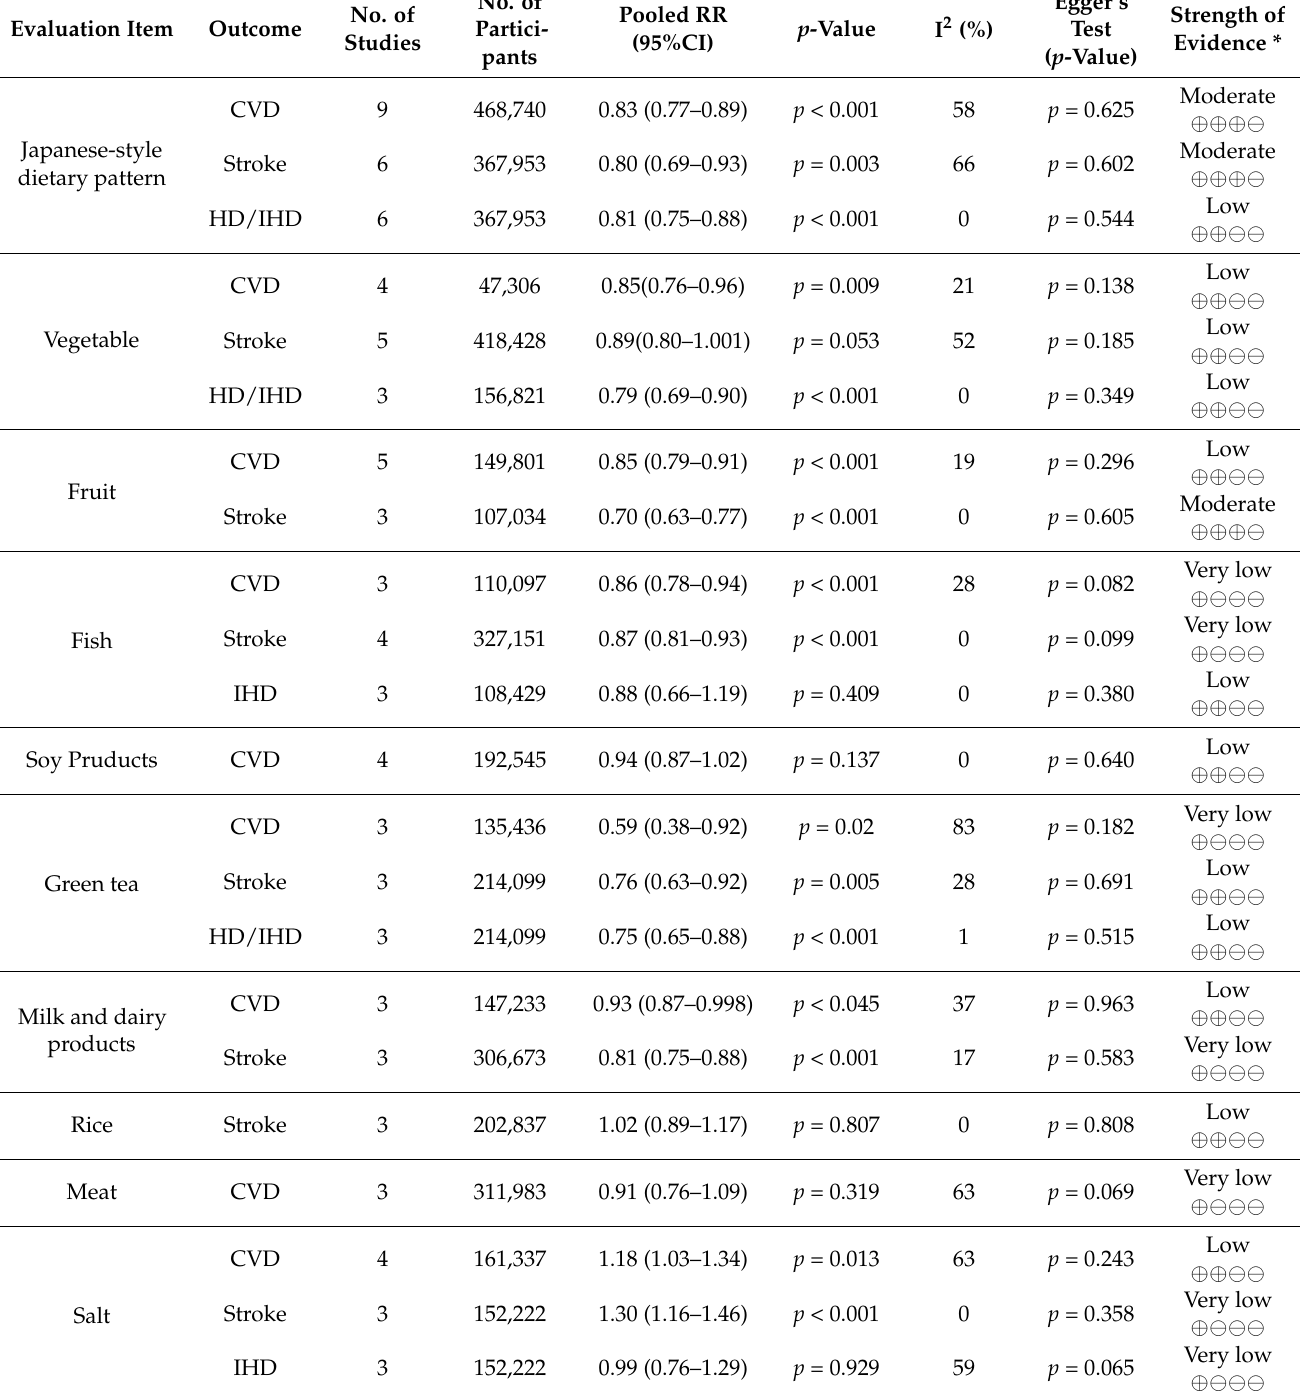
Table 2. List of meta-analysis results on CVD, stroke, and HD/IHD mortality